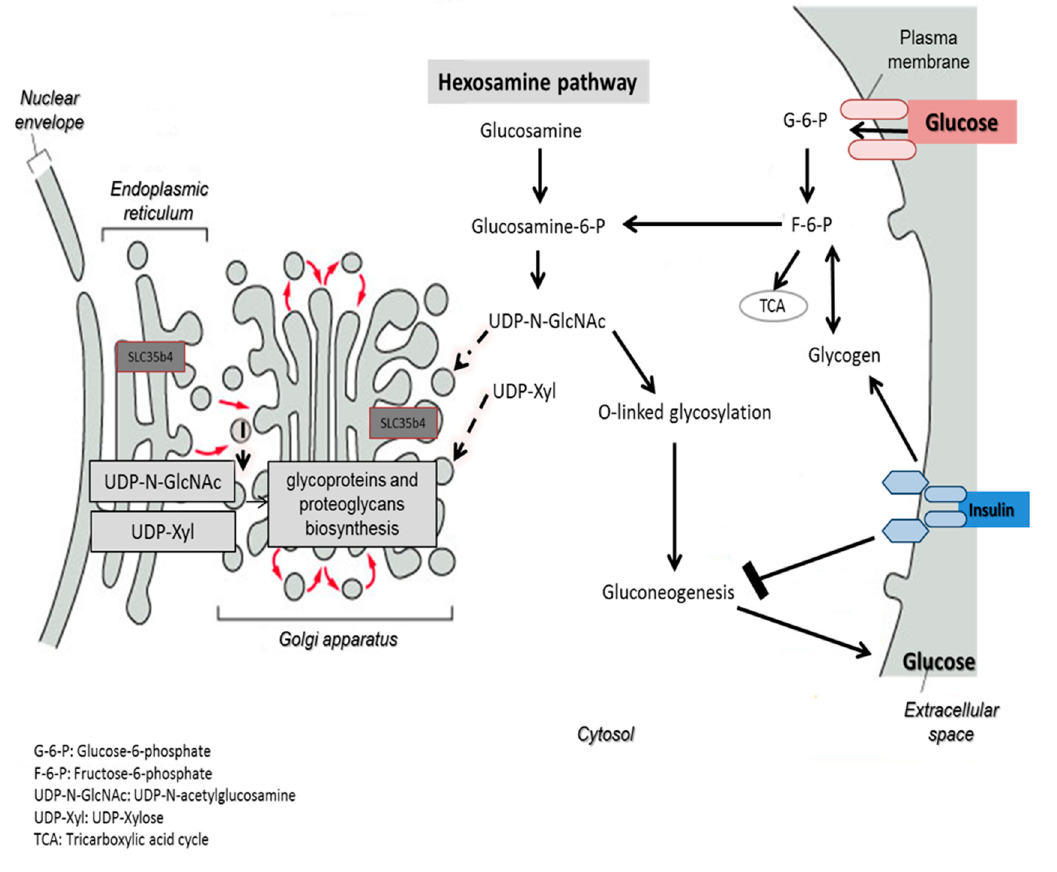
Figure 7. Schematic representation of the potential function of SLC35B4 . The uptake of UDP-GlcNAc by the SLC35B4 carrier reduces the O-linked glycosylation by depleting the substrate for the O - GlcNAc transferase. This process reduces gluconeogenesis leading to a decrease in glucose